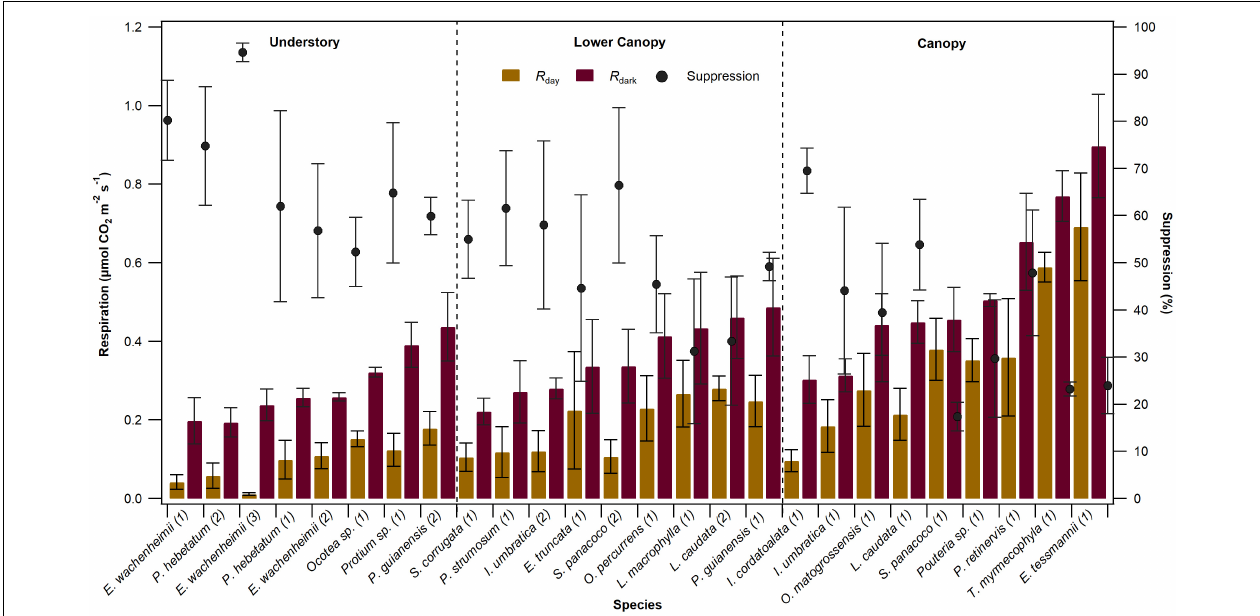
FIGURE 2 | Respiration rate measured in the light (R day , brown bars) and in dark adapted leaves (purple bar), and light suppression (black point) for each individual studied. The number after the specie name represent the number of individuals per specie studied. Values are mean ± standard error ( n = 2–3). Data are organized in function of crown position, understory, lower canopy, and